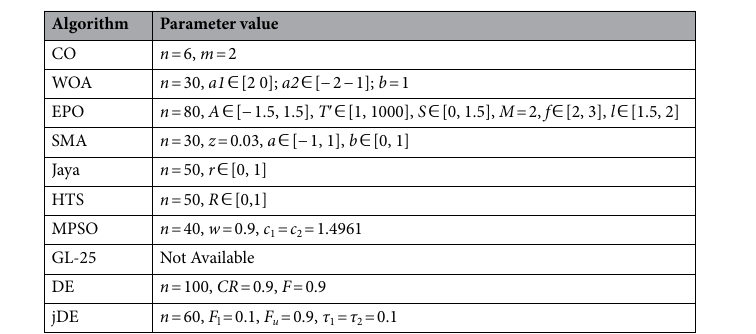
Table 4. Parameter setting of competing algorithms for solving 30-D shifted-rotated CEC2005 test